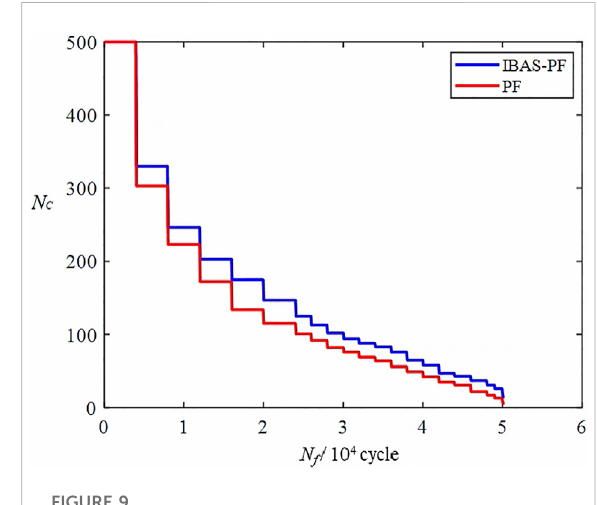
FIGURE 9 The N C values corresponding to different fatigue cycles N f